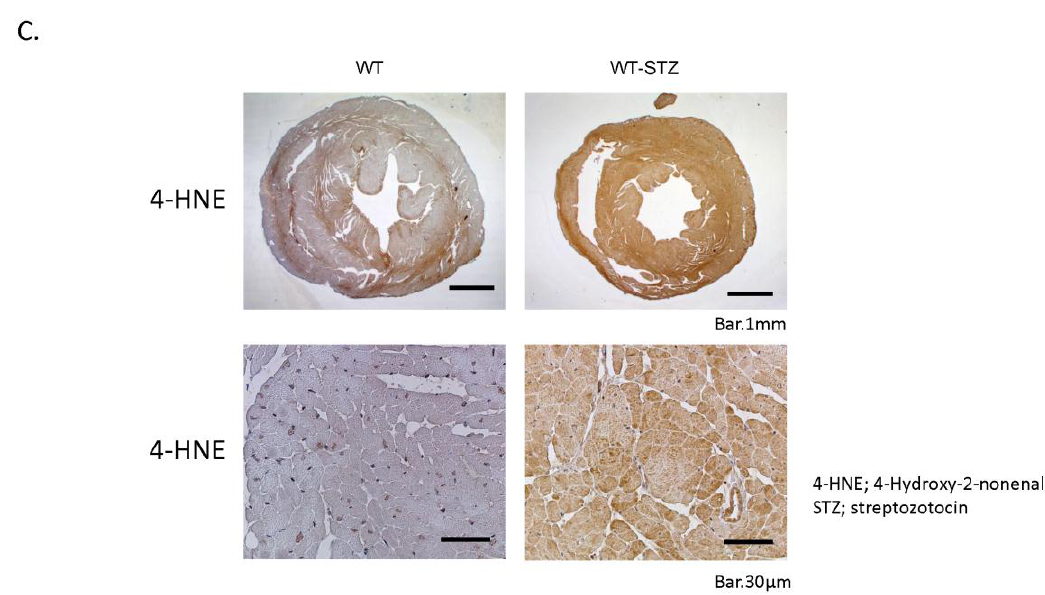
Figure 4. ROS production and oxidative stress in the diabetic heart in vitro and in vivo . (Copyright 2015 American Diabetes Association from [44]. Reprinted with permission from The American Diabetes Association). ( A ) Hyperglycemia-induced ROS production and mitochondrial membrane potential in cardiomyocytes. Intracellular ROS level is increased in cardiomyocytes (CM) expose to high glucose (HG) by using chloromethyl-2,7- dichlorodihydro-fluorescein diacetate (CM–H2DCFDA). There was loss of mitochondrial membrane potential (ΔΨ m ) in CM expose to high glucose as indicated by a decrease in the fluorescence intensity assessed using Mito Tracker red; ( B ) Quantitative results of analysis. ROS production is increased in CM expose to high glucose (HG). CM-H2DCFDA, intracellular ROS in cardiomyocytes. Mito tracker, assessment of the mitochondrial membrane potential. HG (high glucose treatment), 25 mmol/L glucose; LG (low glucose treatment), 5.5 mmol/L glucose. * p < 0.05 vs. LG. Error bars indicate s.e.m. n = 4–6; ( C ) Cardiac oxidative